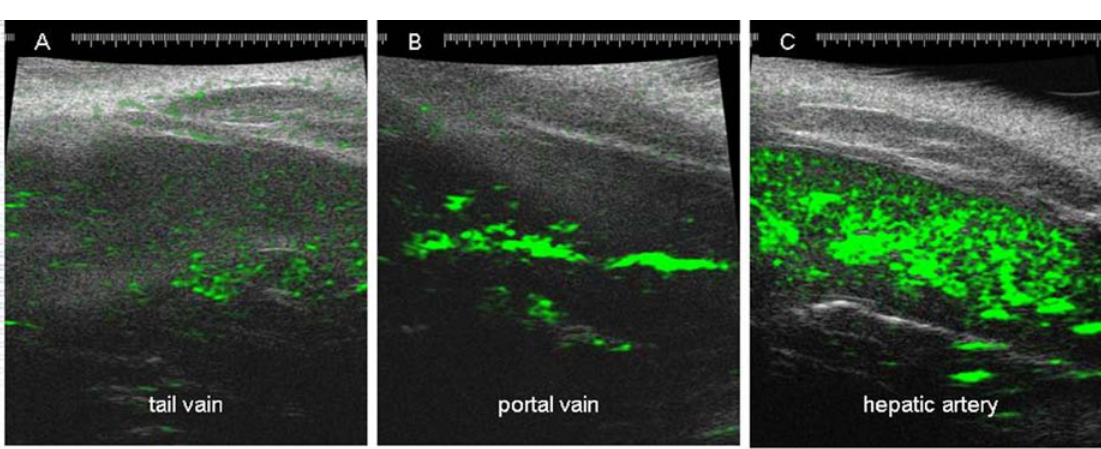
Figure 4. Ultrasound images of rat livers following bolus injection of microbubbles (50 mL) into the tail vein ( A ) portal vein ( B ) or hepatic artery ( C ). Take of the microbubble contrast (green) by the liver is very high if the injection is made through hepatic artery or portal vein, but poor if injection is made through the tail